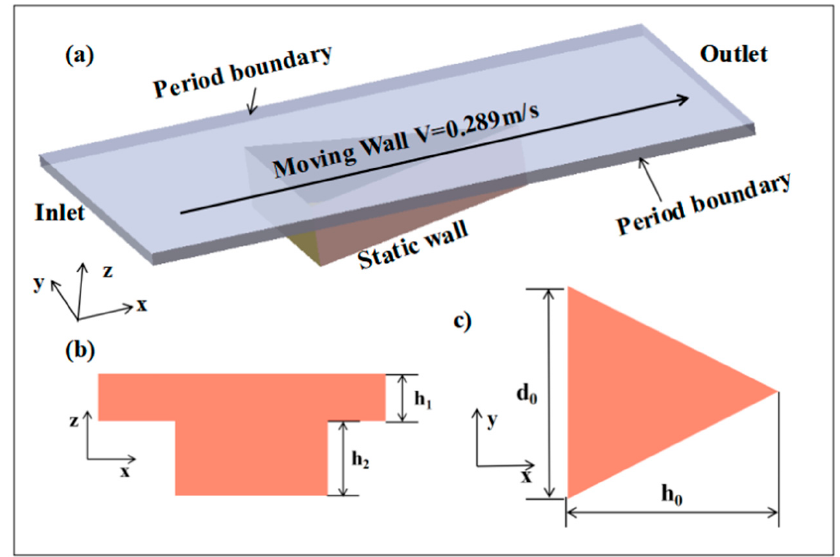
Figure 4. ( a ) Boundary conditions of single-texture flow field model. ( b ) Texture size. ( c ) Oil film depth.